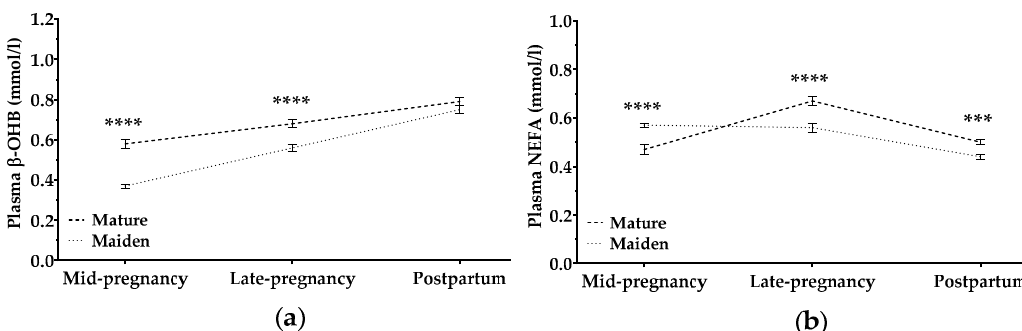
Figure 7. Concentration of ( a ) β -hydroxybutyrate ( β -OHB) and ( b ) non-esterified fatty acids (NEFA) in plasma (both mmol/L) in mature ewes (dashed line) and maiden sheep (dotted lines) throughout the study period. The time × age-group interaction was significant ( p < 0.0001). Data are mean ± S.E.M. Asterisks indicate significant differences between age groups at each time point (**** p < 0.0001; *** p < 0.001).